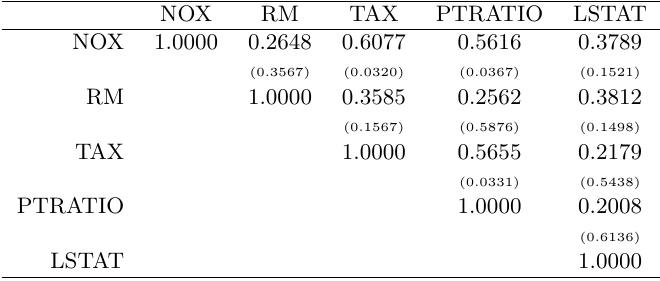
Maximal local correlation, Boston Housing reduced